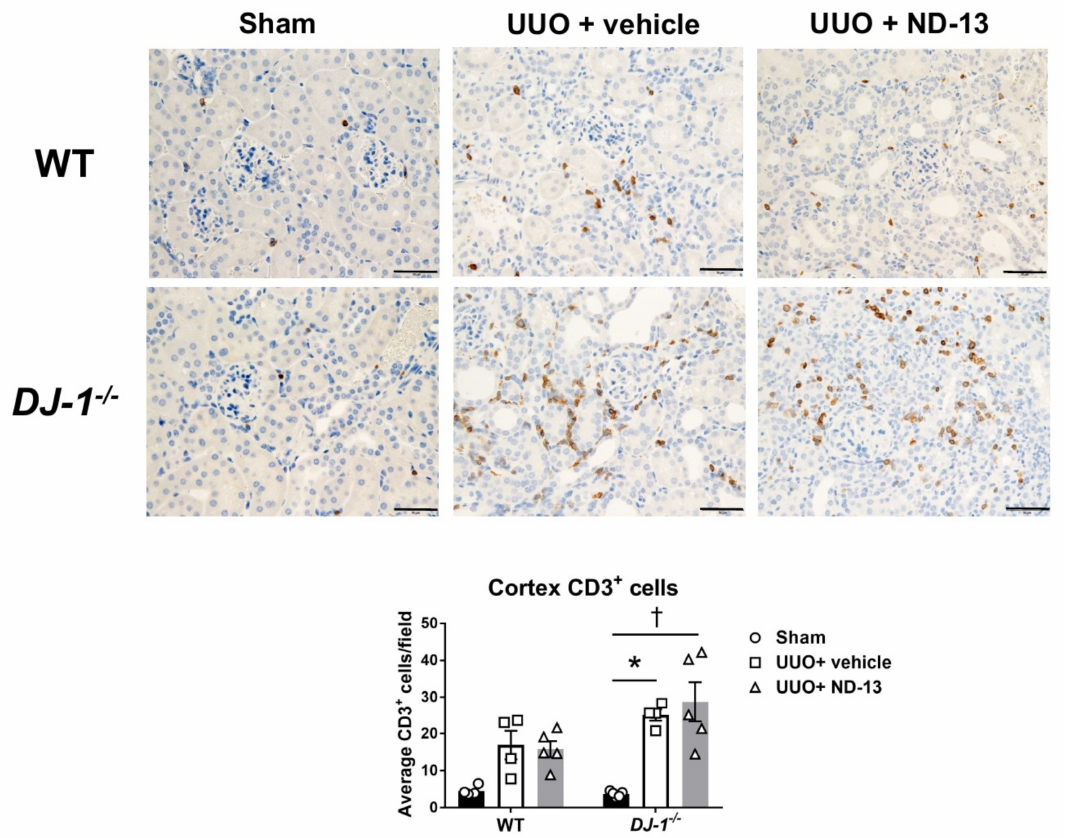
Figure 6. Treatment with ND-13 does not prevent the UUO-induced infiltration of T cells into the kidney cortex of mice that underwent UUO. Representative images and quantification of T cell (CD3 + cells) infiltration in renal cortex of WT (upper panels) and DJ-1 − / − (bottom panels) mice that underwent sham surgery, UUO and vehicle treatment or UUO and ND-13 treatment (scale bar = 20 µ m). * p < 0.05 vs. same genotype sham, † p < 0.05 vs. same genotype UUO + vehicle; two-way ANOVA with Tukey’s post hoc